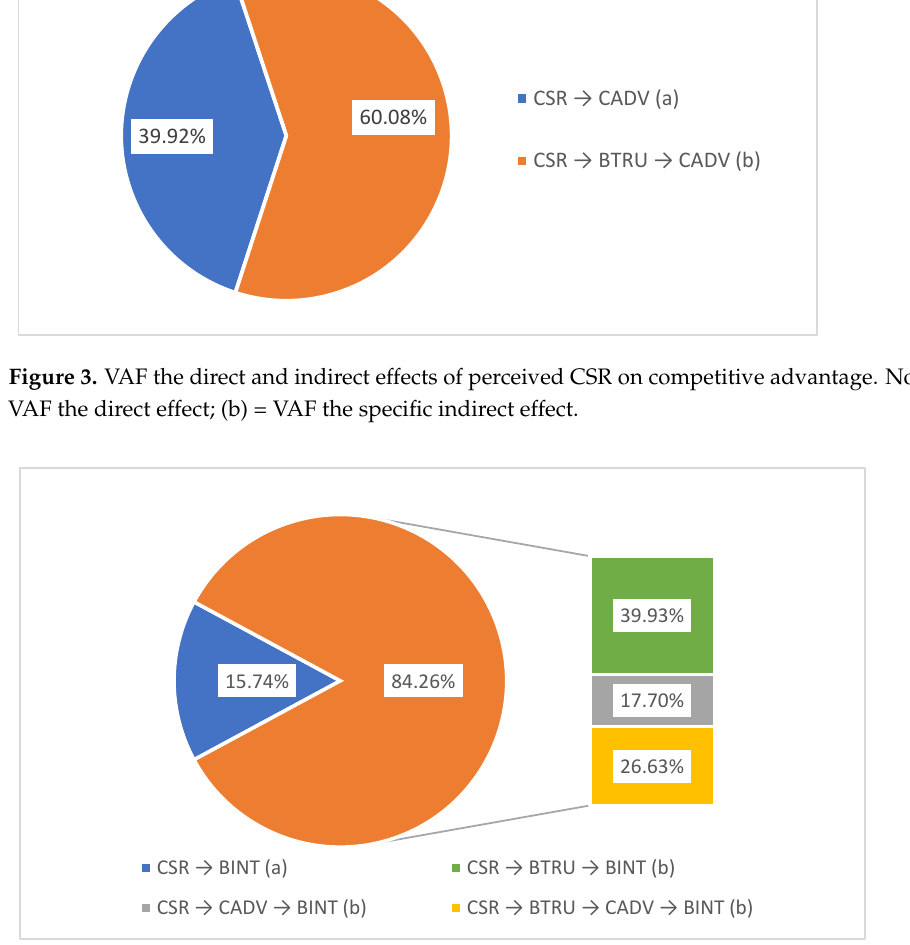
Figure 4. VAF the direct and indirect effects of perceived CSR on buying intention. Note: (a) = VAF the direct effect; (b) = VAF the specific indirect effect.